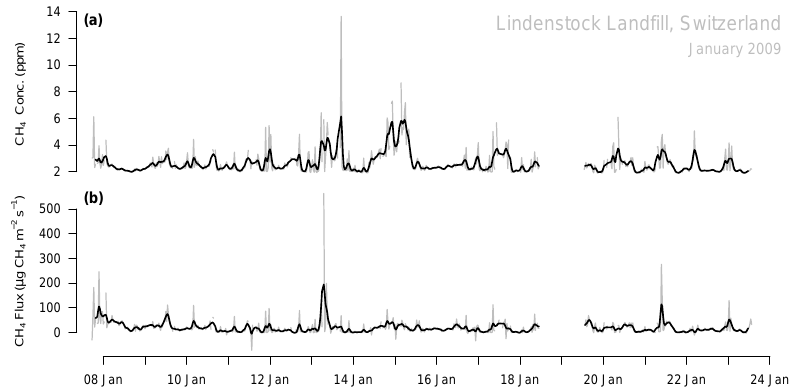
Figure 4. Example of episodic CH 4 flux peaks from a landfill site in Switzerland during winter with snow cover (following the period reported by Schroth et al., 2012). (a) CH 4 concentration and (b) CH 4 flux. Thin gray lines show 30min averages, and the bold black line is the running average using a 4.5h Gaussian filter. The instruments were carefully checked ≈ 4h after the significant flux peak on 13 January 2009.